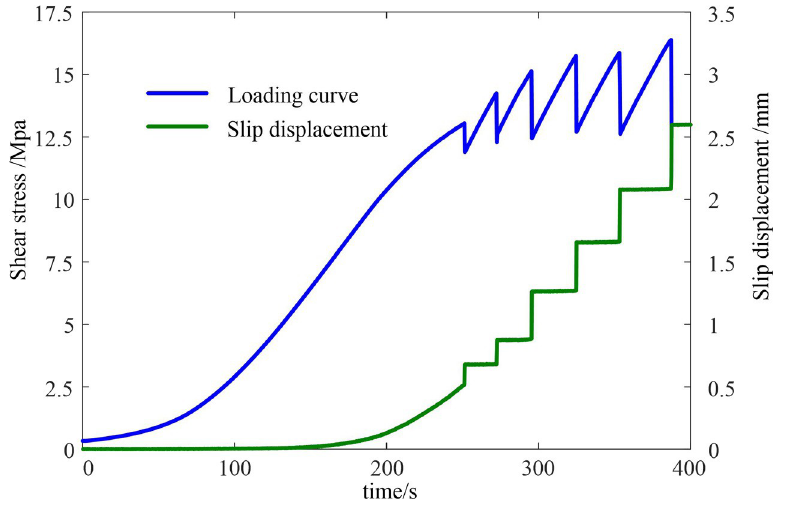
Fig 7. The shear stress and fault slip displacement